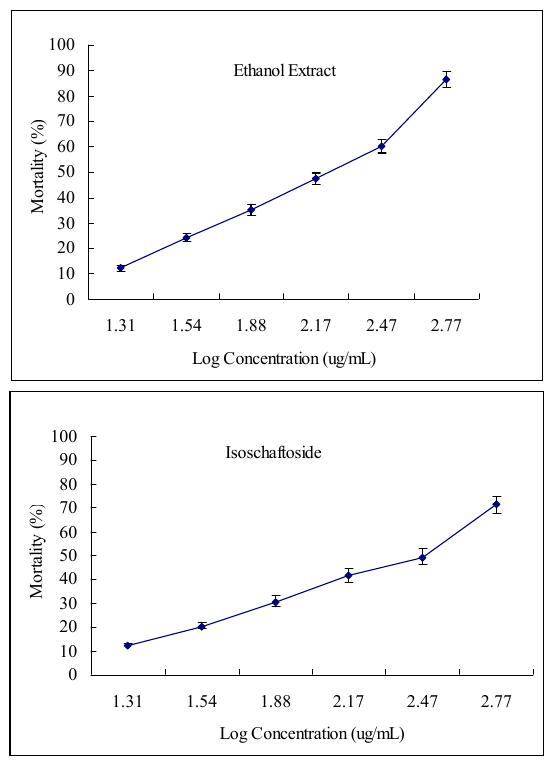
Figure 2. Dose-response curves of Meloidogyne incognita (J2) treated with ethanol extract of A. erubescens and the two